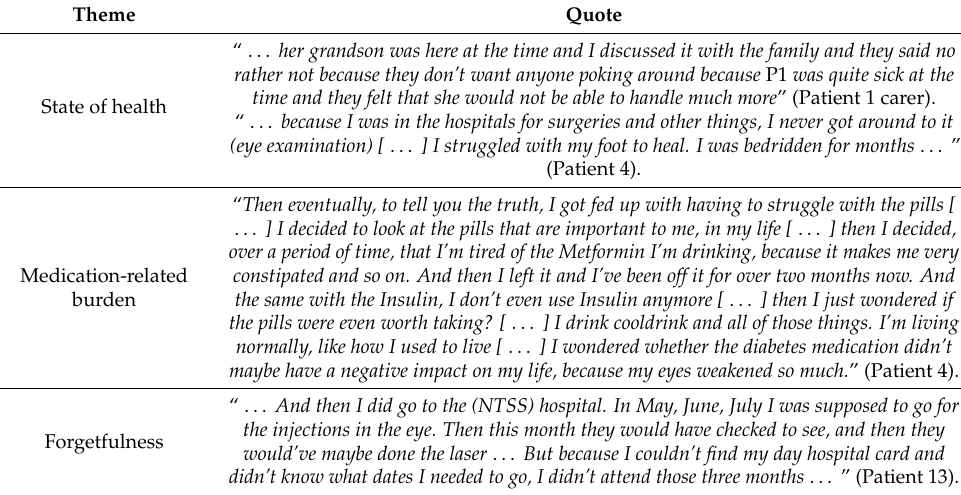
Table 5. Individual